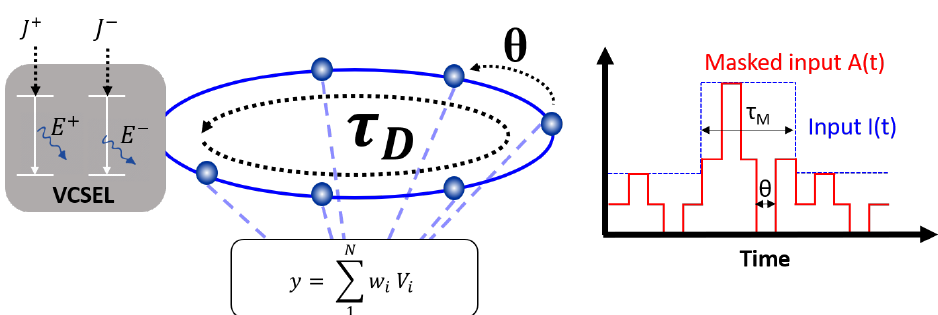
Figure 1. ( left ) Schematic overview of our setup, consisting of a spin-VCSEL connected to a feedback line with delay τ D . The spin-up and spin-down populations are pumped separately by J + and J − , respectively. ( right ) A simplified plot showing the input data I ( t ) in blue, the masked input data A ( t ) in red and the timescales of τ M and θ